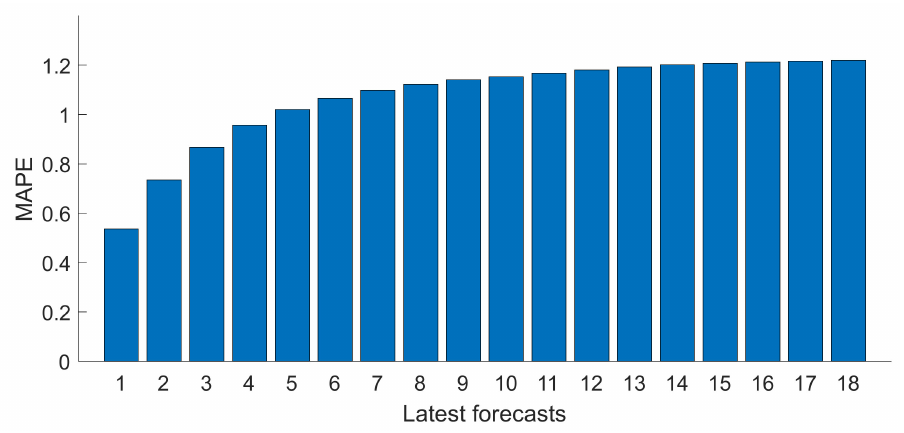
Figure 6. MAPE of latest